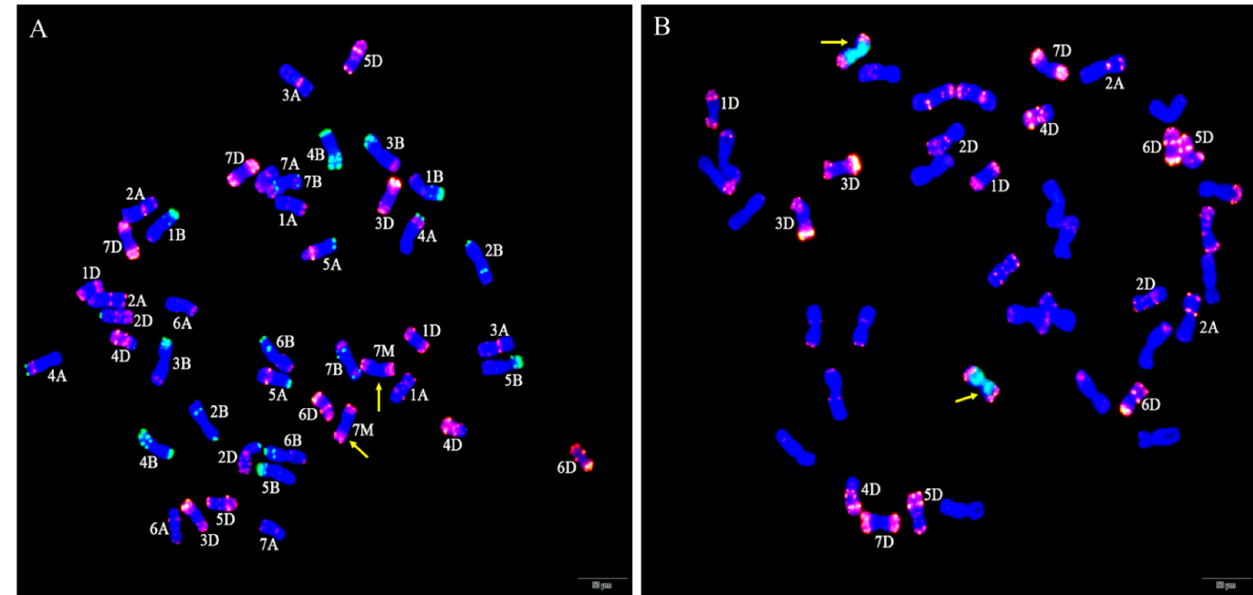
Figure 3. FISH and special GISH analysis. ( A ) Oligo-pSc119.2 (green) and Oligo-pTa535 (red) as probes used in W166. ( B ) Ae. geniculata genomic DNA (green), Oligo-pTa535 (red) as probes, and shared CS genomic DNA as a blocker in W623. The yellow arrows indicate Ae. geniculata chromosomes. Table 1. EST-STS and PLUG markers used in this study of W623 and